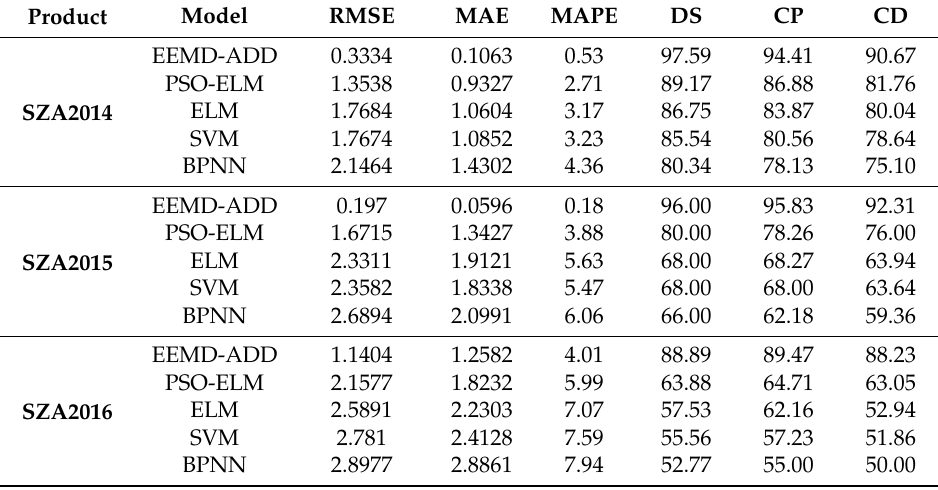
Table 10. The statistics of the three additional carbon emission allowance